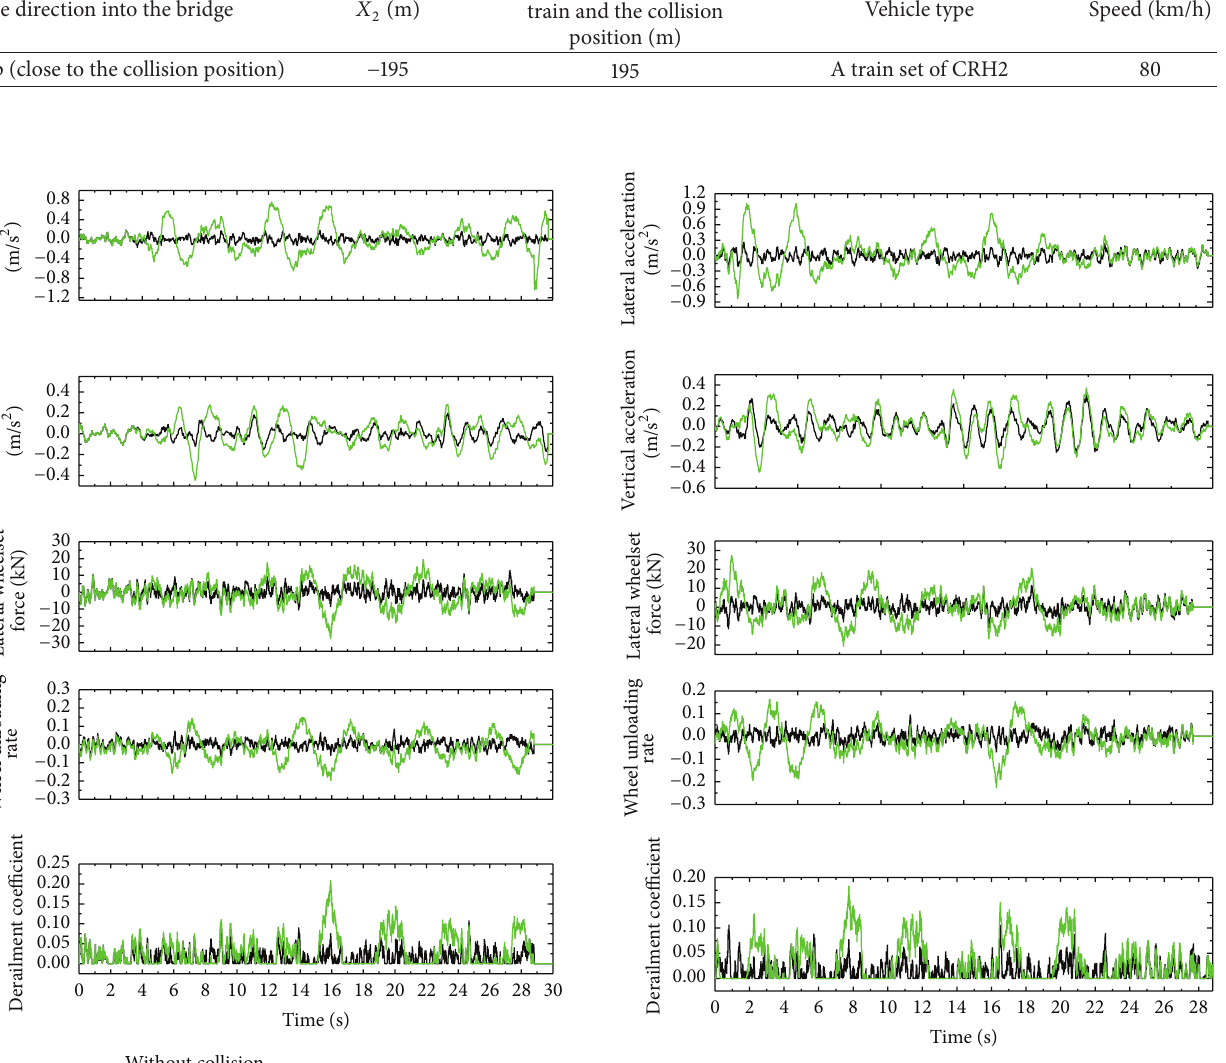
80 km/h, in the up